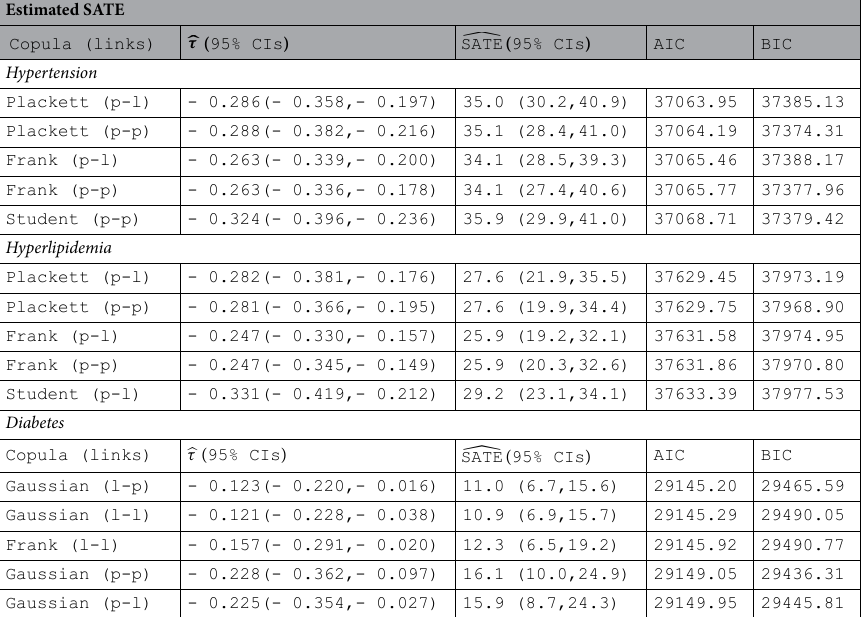
Table 3. Estimated SATE (in %), Kendall’s τ , AIC and BIC obtained using different copula models for the 2012 MEPS data. 95% confidence intervals for the SATE have been obtained using the method detailed in Section “Semiparametric recursive bivariate copula model”. For the link functions, the probit link is represented by p , while for the logit and cloglog links we use l and c respectively. For example, (l-p) refers to a logit link for the outcome equation ( l ) and a probit link for the treatment equation ( p